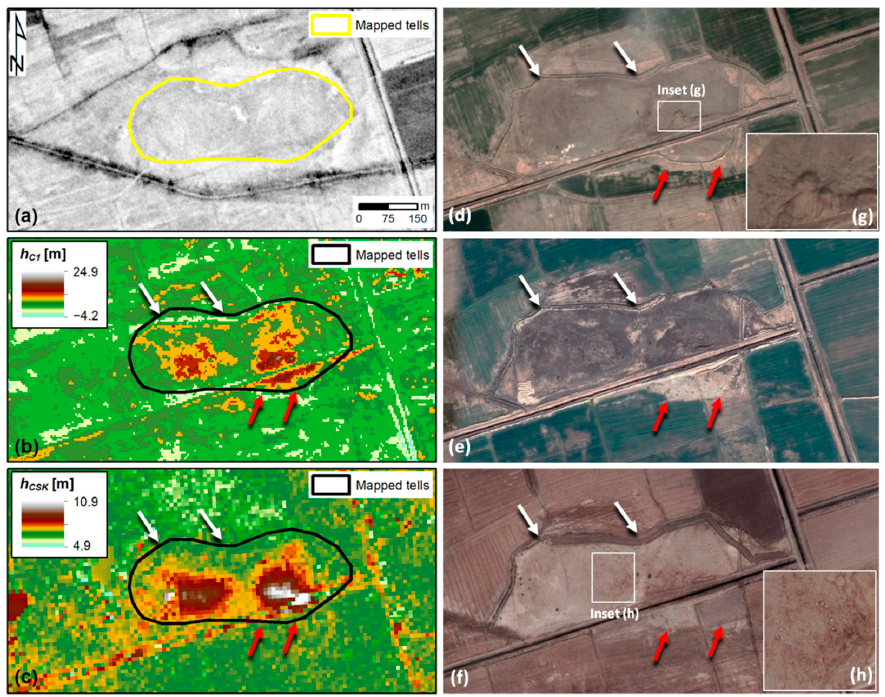
Figure 12. Example of tell (precise location undisclosed for security concerns) affected by ‘reworking and reshaping’ and ‘looting’ incidents, as documented by multi-temporal analysis of: ( a )